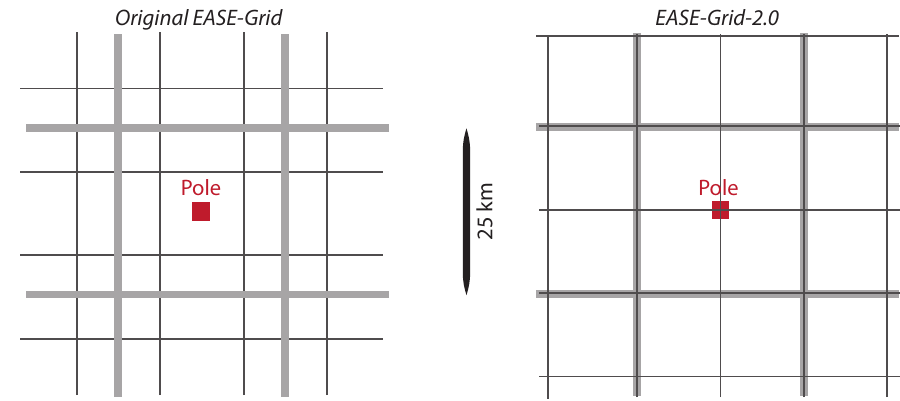
Figure 5. Relative gridding schemes for representative azimuthal 25 km and 12.5 km original EASE-Grid (( Left ), bore-centered) vs . EASE-Grid 2.0 (( Right ), nested) cells near the pole. Original EASE-Grid EASE-Grid-2.0